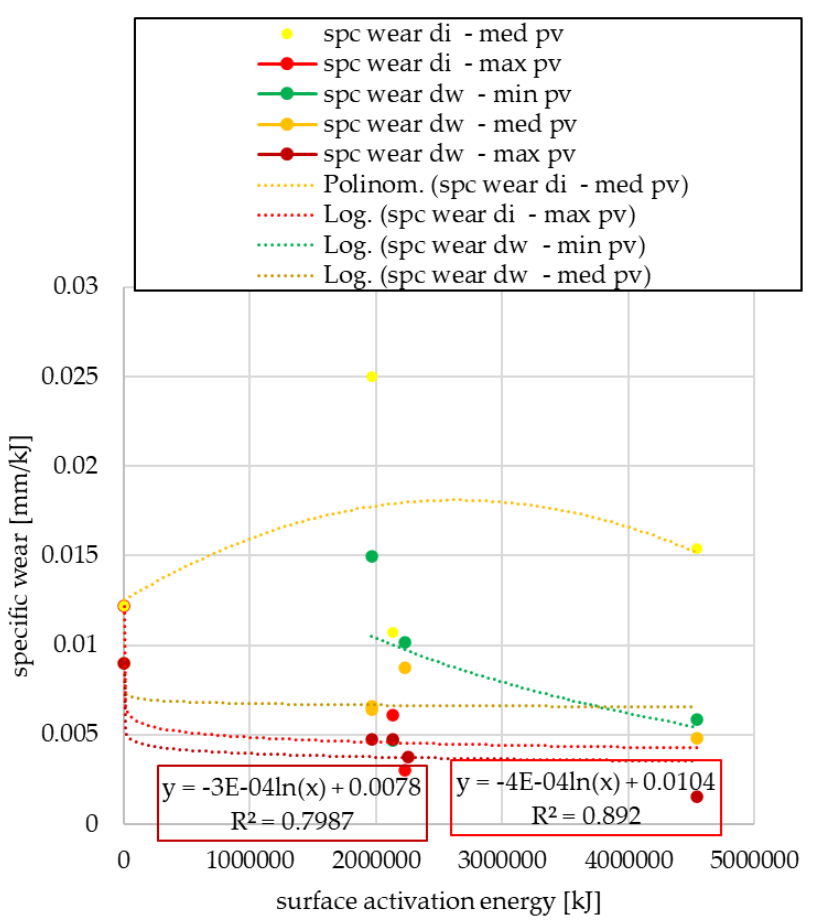
Figure 10. Specific wear values as a function of surface activation energy — normal use facings.